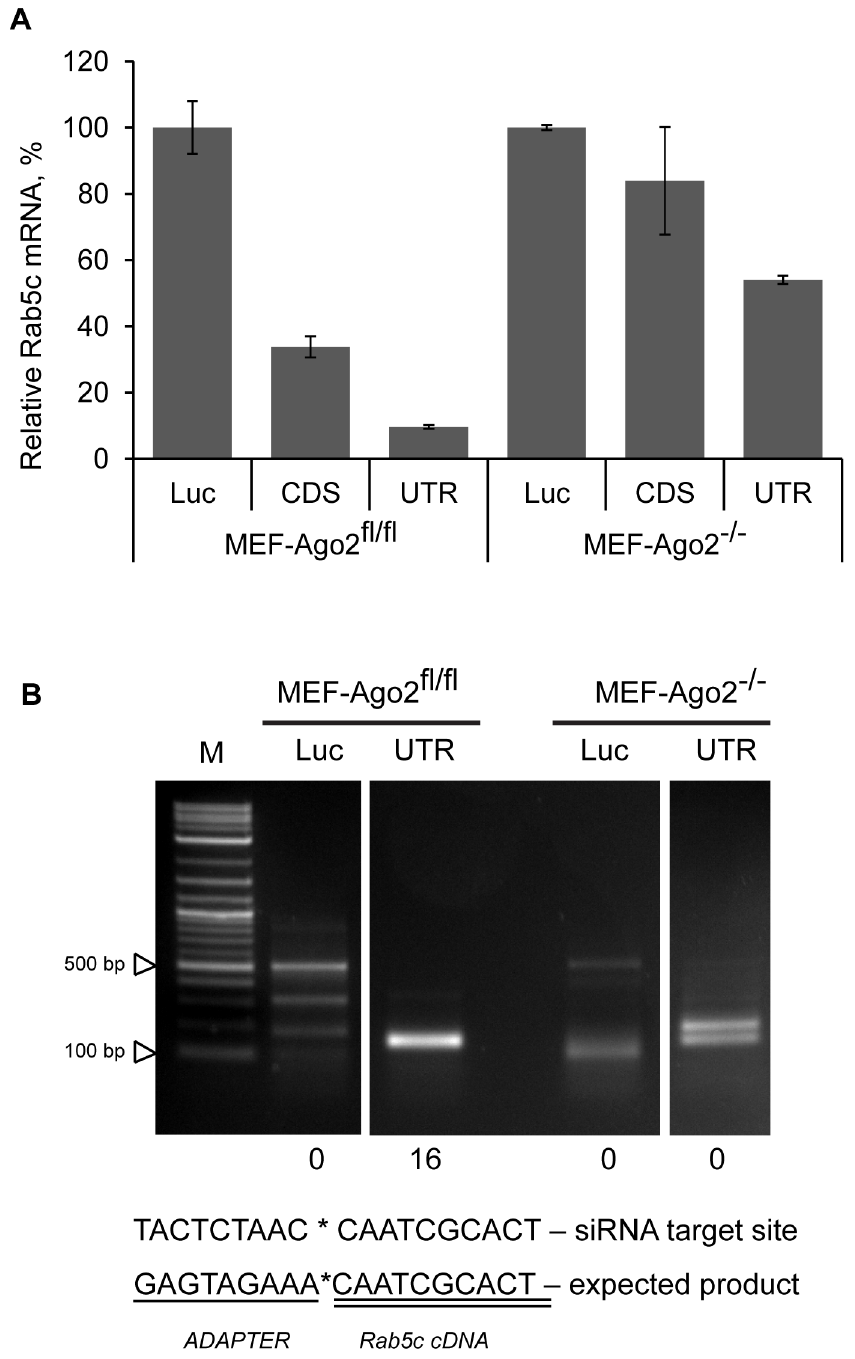
Figure 2. Cleavage independent siRNA-mediated degradation of mRNA in the absence of Ago2. Ago2 fl/fl MEF cells and Ago2 2 / 2 MEF cells were transfected with 10 nM of siRNAs targeting Luciferase, or CDS, or 3 9 UTR of the Rab5c mRNA. bDNA assay (A) and 5 9 RACE (B) were performed on total RNA isolated from cells 3 h post-transfection. (A) Data is presented as mean 6 s.d. for two technical replicates of bDNA measurement. (B) 5 9 RACE nested PCR detection of cleavage product. Numbers of clones bearing expected inserts are indicated below corresponding lanes of the gel (expected PCR product length is 145 bp; expected adapter/Rab5c junction sequence is shown below; 16 clones were sequenced for each PCR reaction). doi:10.1371/journal.pone.0101749.g002 knockdown in Ago2 fl/fl MEF cells and insignificant knockdown in Ago2 2 / 2 MEF cells. Thus, the depth of 3 9 UTR-targeted knockdown in the presence of Ago2 does not predict the depth of Ago2 independent mRNA knockdown.